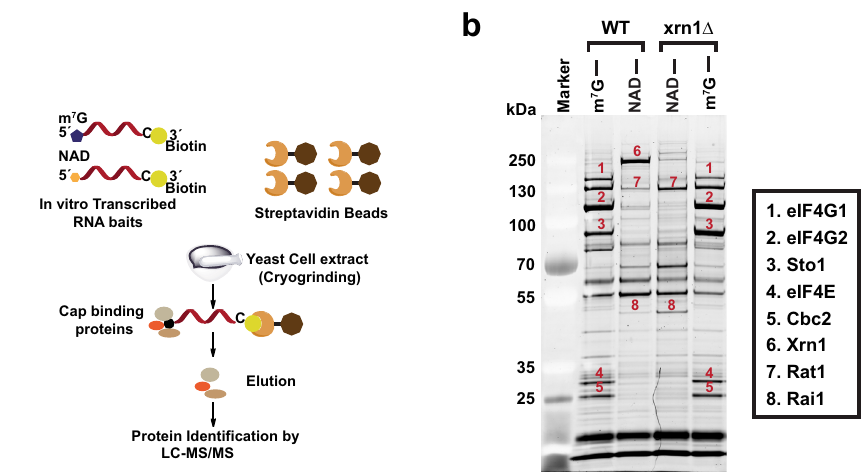
Fig. 1 Identi fi cation of NAD cap-binding proteins in budding yeast. a Schematic illustration of the NAD cap -RNA Af fi nity Puri fi cation (NcRAP). b Eluates from NcRAP were loaded on to a 4 – 12% Bis – Tris gel and stained with SYPRO Ruby. The m 7 G cap af fi nity puri fi cation was used as a control. All protein bands labeled on the gel were excised from the gel and identi fi ed using mass